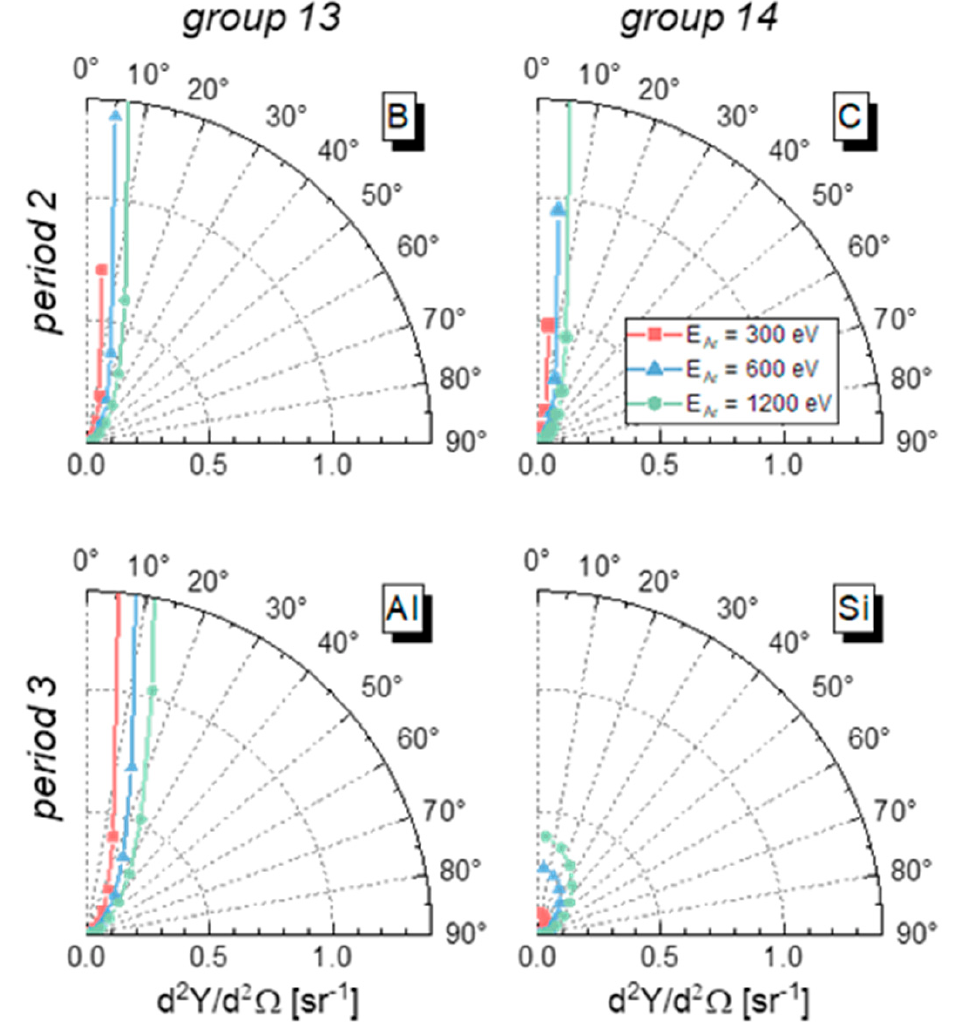
Figure 6. Angular distribution of sputtered light elements (groups 13 and 14) with 300 eV (red), 600 eV (blue), and 1200 eV (green) energy argon ions at perpendicular sputtering directions. The graphs show the number of sputtered atoms in a particular polar angle interval.